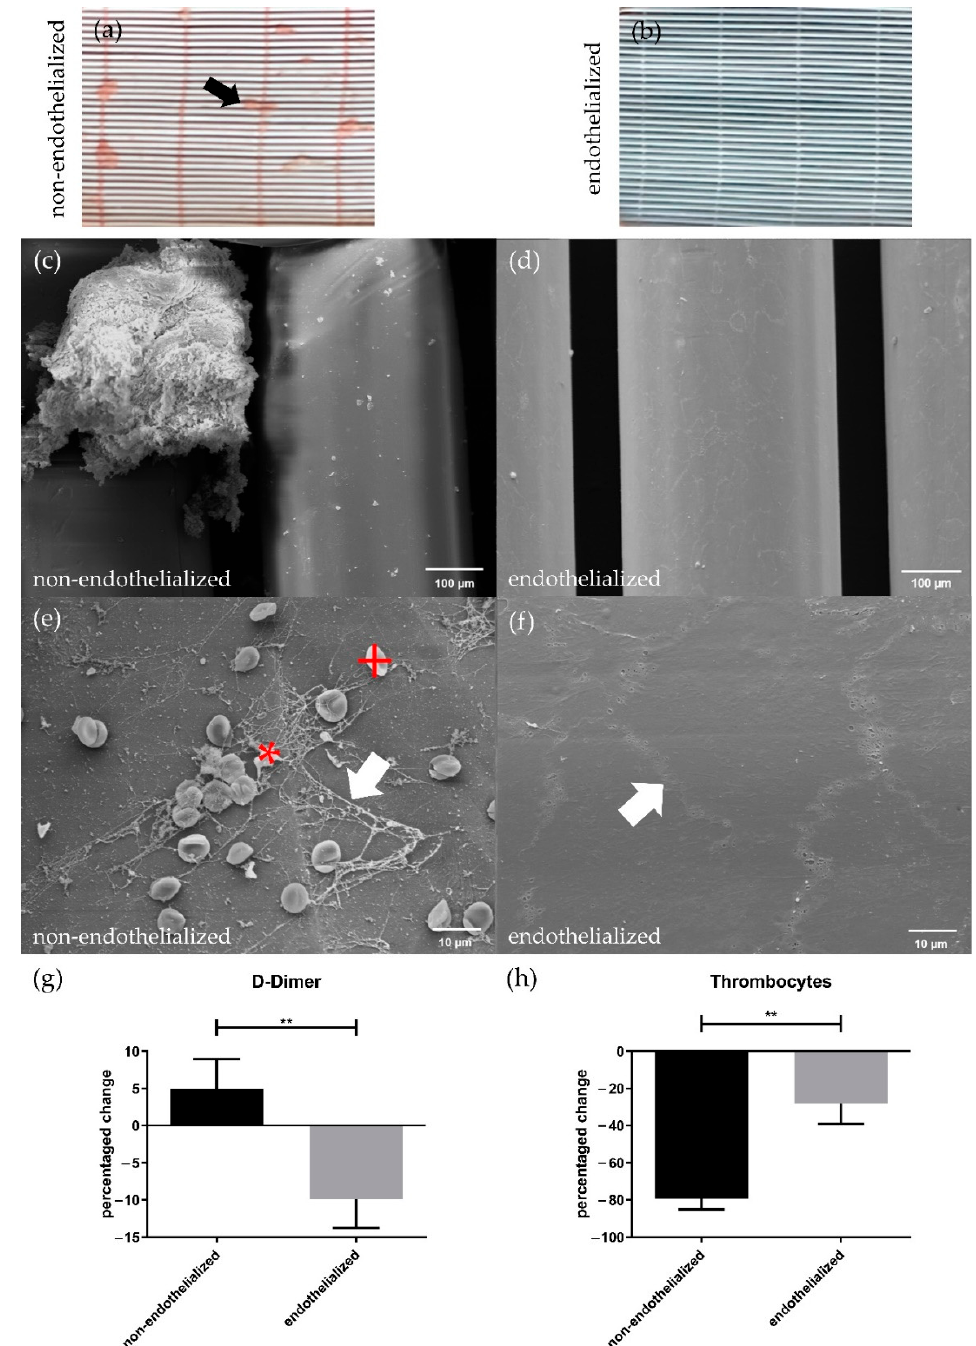
Figure 6. Thrombogenicity assessment of HFMs with and without pCEC monolayer after blood flow exposure. Macroscopic examination of ( a ) non-endothelialized and ( b ) endothelialized HFMs; ( a ) black arrow = macroscopically visible thrombus; SEM images of ( c , e ) non-endothelialized and ( d , f ) endothelialized HFMs; ( e ) white arrow: fibrin, red +: erythrocyte, red *: thrombocyte; ( f ) white arrow: cell-cell contact within confluent EC-monolayer; ( g ) D-Dimer and ( h ) thrombocyte count level changes in the non-endothelialized and endothelialized HFM group before and after blood flow exposure. An unpaired t -test was used to compare both groups. Results are given in mean difference [%] with SD ( n = 3) (** p <